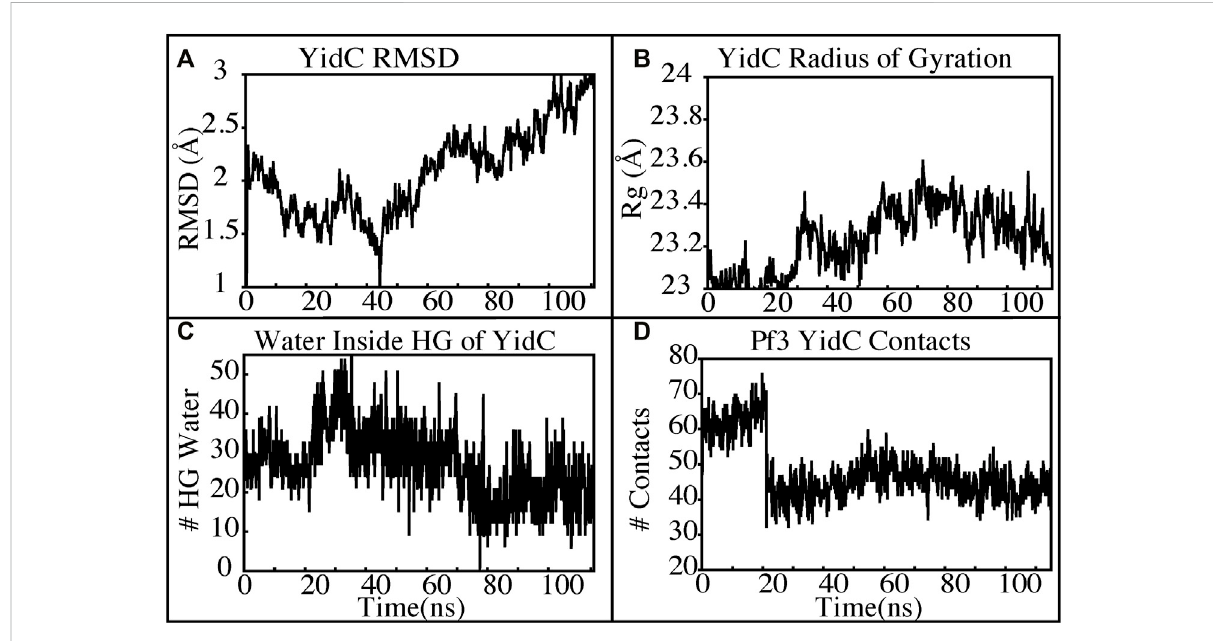
FIGURE 9 YidC conformational changes observed in the targeted MD simulations. (A,B) Root mean square deviation and radius of gyration of YidC in the insertion processofPf3. (C) Thewater contentinthehydrophilic grooveoftheproteinduring a100 nsNEsimulationfollowedbya15 nsequilibrium simulation. (D) Interaction of YidC with Pf3 coat protein in the NE simulation